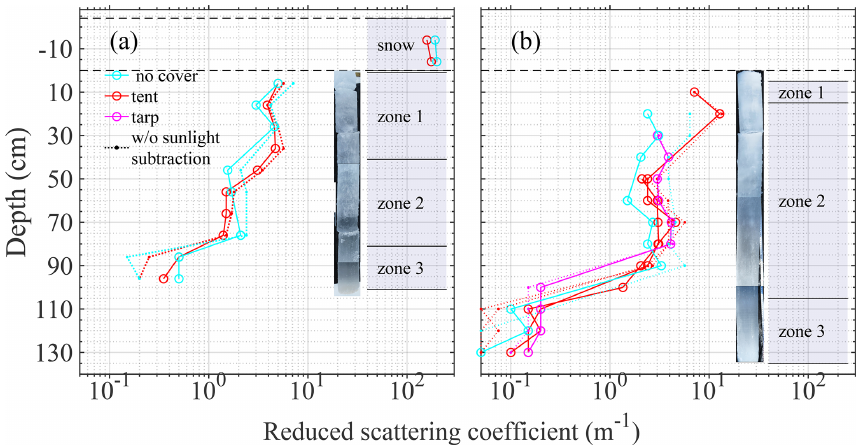
Figure 9. Reduced scattering coefficient b (cid:48) vs. depth measured actively in situ inside first-year Arctic interior sea ice. Measurements were taken (a) at a snow-covered site and (b) at a bare-ice site. Pictures show ice cores extracted a few metres away from the sampling holes. The profiles were separated by zones at depth where we observed significant changes in the value of b (cid:48) . We compared measurements using different covers to shade from sunlight. We also compared with and without subtracting the residual sunlight background flux (cid:56) bg .